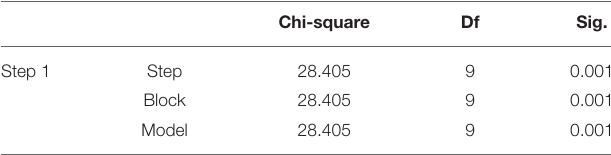
TABLE 9 | Omnibus tests of model coefficients.